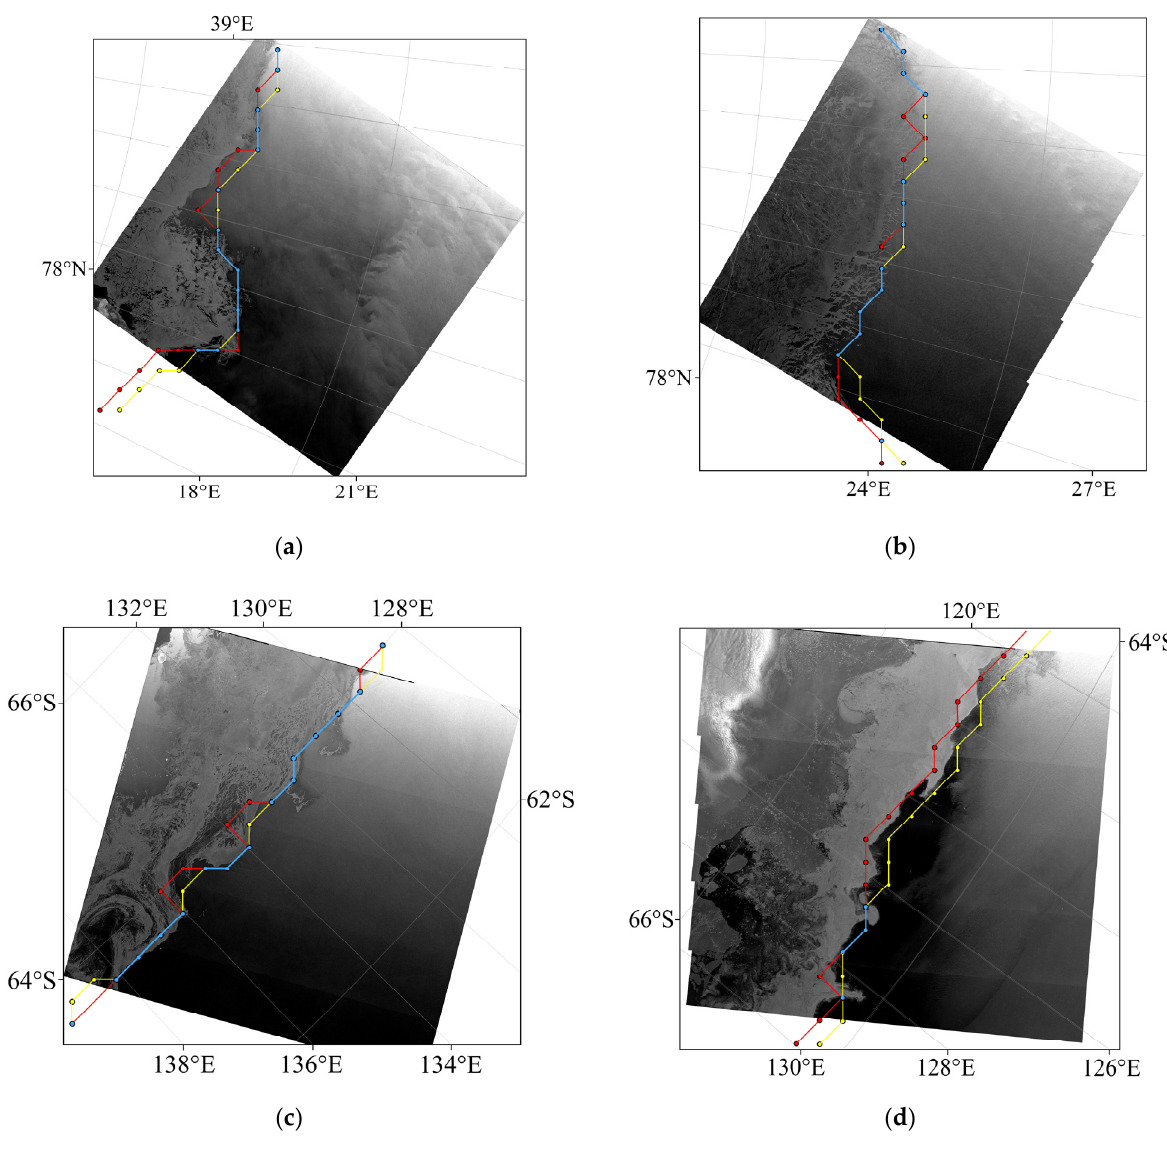
Figure 11. Sentinel-1 SAR images showing sea water and ice distributions. Sea ice edge lines from the multisource scatterometer data (red lines) and NSIDC SIC 15% sea ice (yellow lines) are overlapped, with the blue line being the common overlay sea ice edge line. The image acquisition dates were: ( a ) 4 December 2021, ( b ) 24 December 2021, ( c ) 29 November 2021, and ( d ) 18 December 2021.